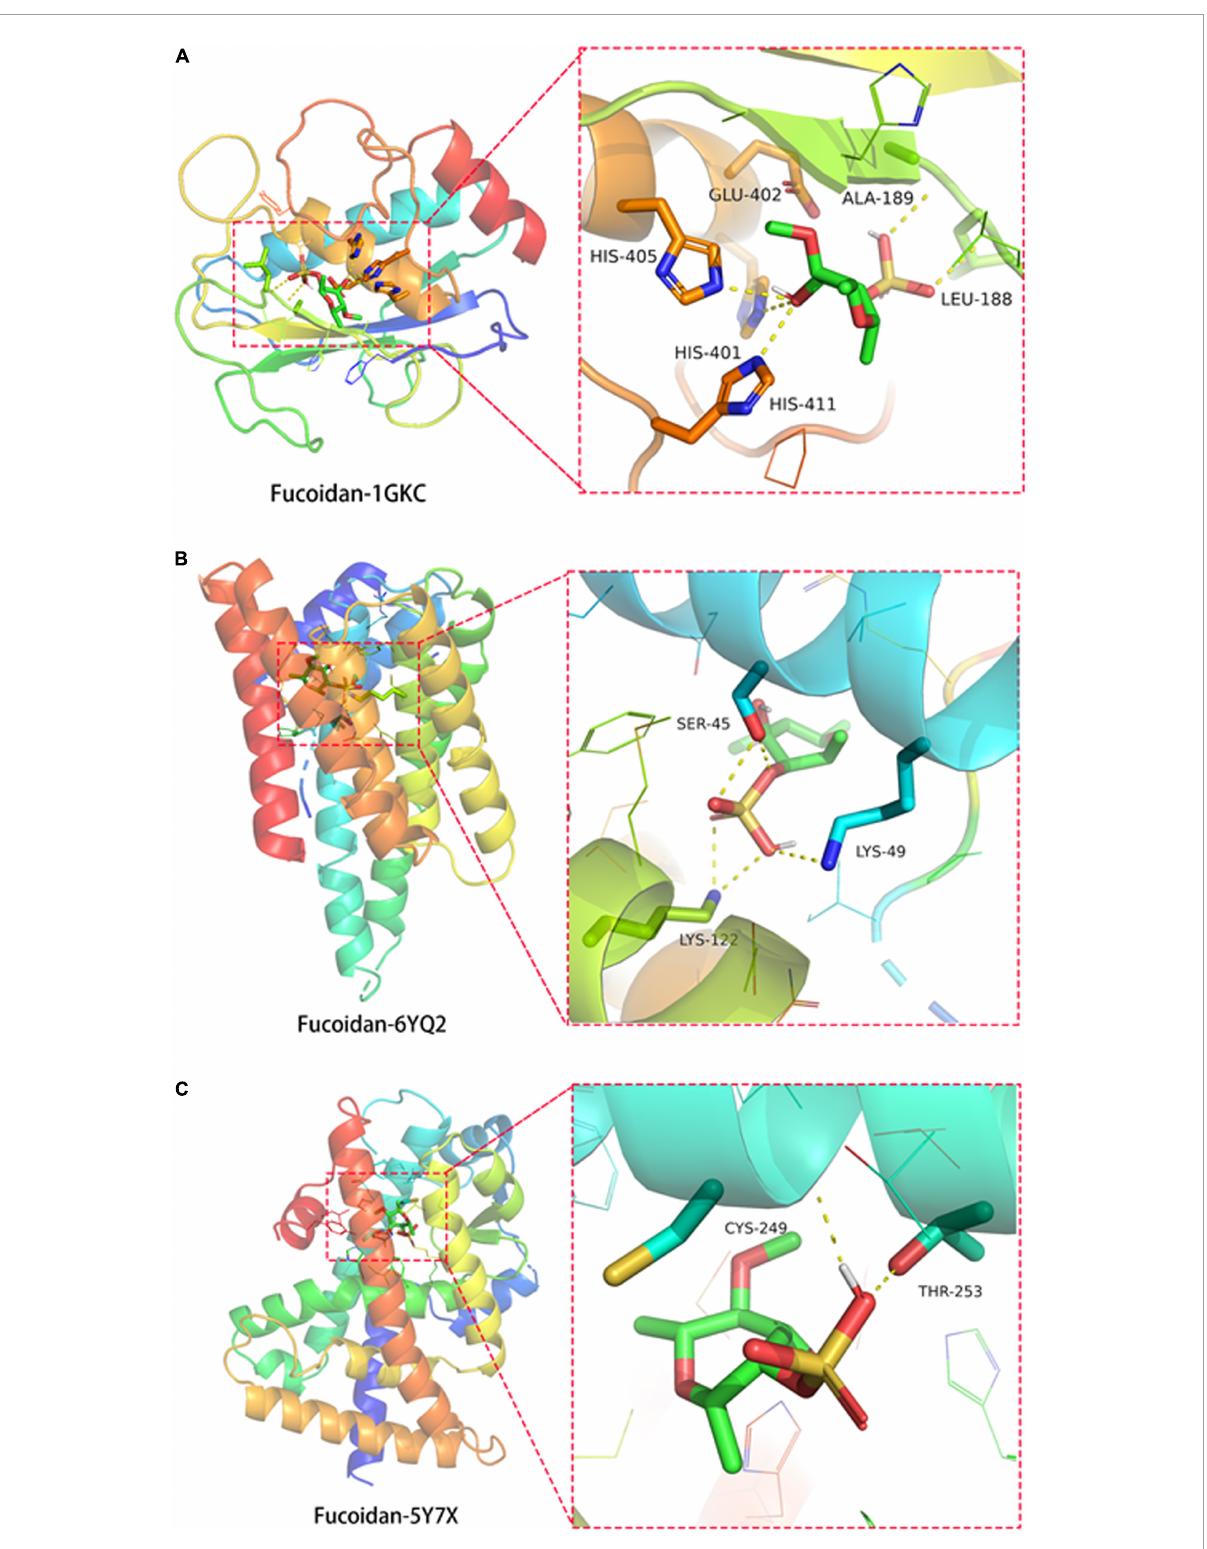
FIGURE3 Direct binding of fucoidan to its target proteins matrix metallopeptidase 9 (MMP9), RELA Proto-Oncogene, NF-KB Subunit (RELA), and peroxisome proliferator-activated receptor delta (PPARD). Molecular docking showed the binding of fucoidan to (A) MMP9 (ID: 1GKC), (B) RELA (ID: 6YQ2), and (C) PPARD (ID: